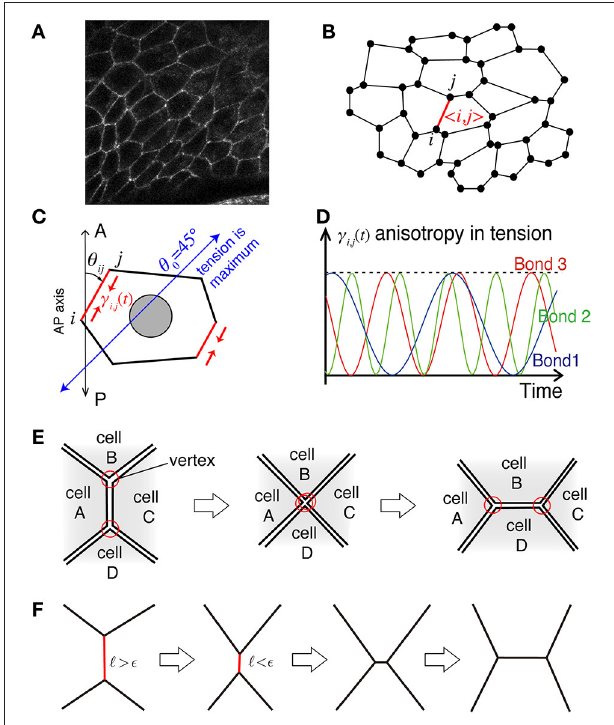
FIGURE 1 | Illustration of the mathematical model. (A) Actual cell–cell junctions visualized with E-cadherin. The epithelial cell monolayer resembles polygons whose shared sides correspond to cell–cell junctions. (B) The cell vertex model in two dimensions, modeling the polygon-like structure of the network of cell–cell junctions. The vertex index is indicated by i and j , and the i , j bond index is given by . (C) Bond-dependent tension strength. When the h i bond is tilted in the clockwise direction by θ 0 45 ◦ from the AP axis, the line = tension of the bond is maximum. (D) The heterogeneity in line tension strength in the model. (E) Process of junctional remodeling, called a T1 transition. Lines indicate the edges of cells. (F) T1 transition process in the numerical